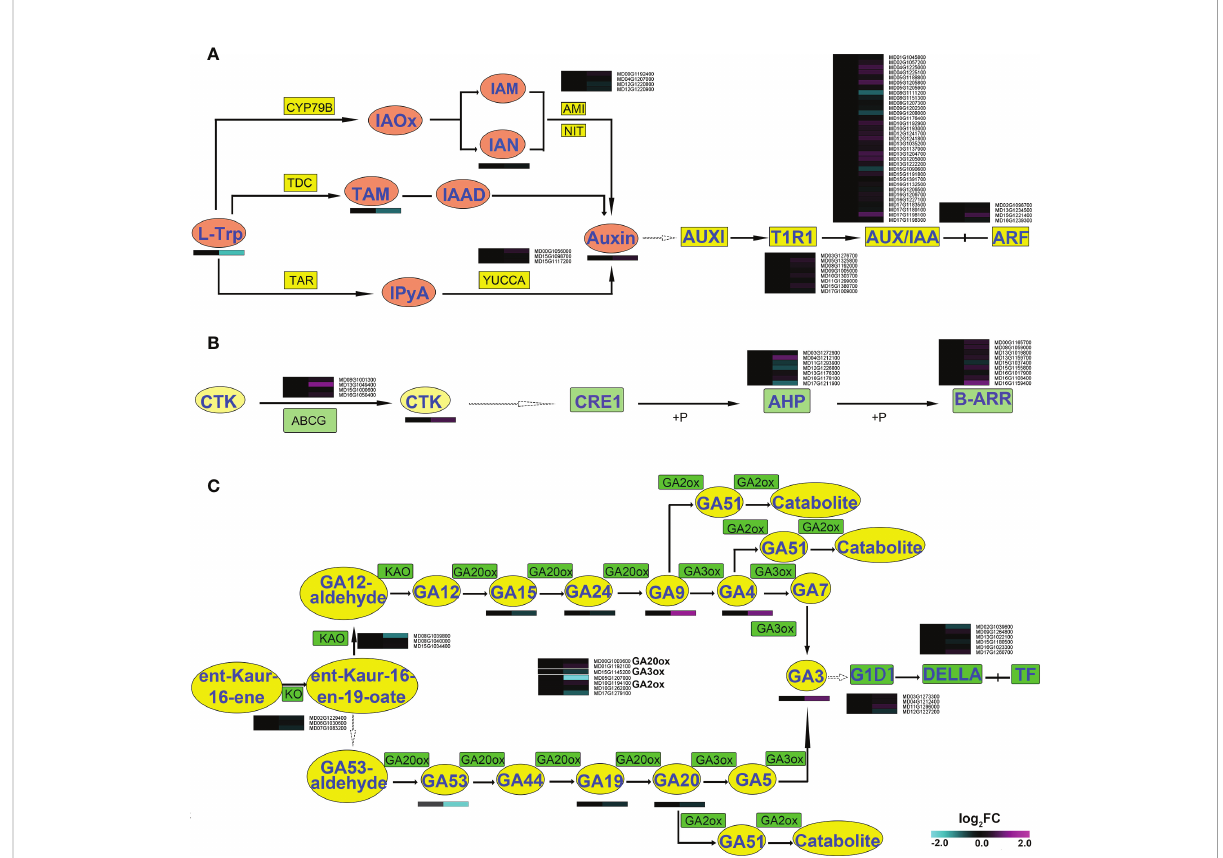
FIGURE 6 Synthesis, degradation, and transduction pathways of hormones in shoots of apple plants inoculated with R . irregularis for 60 days. (A) AMI1, amidase1; IAA, indole-3-acetic acid; IAAld, indole-3-acetaldehyde; IAM, indole-3-acetamide; IAN, indole-3-acetonitrile; IAOx, indole-3- acetaldoxime; IPyA, indole-3-pyruvic acid; L-Trp, L-tryptophan; NIT, nitrilase; TAR, tryptophan aminotransferase-related; TDC, tryptophan decarboxylase; TIR1, transport inhibitor response1; AUX/IAA, transcriptional regulator family protein; ARF, auxin response factors; (B) CTK, Cytokinin; ABCG, ABC transporter G family member; type-B ARRs, Arabidopsis response regulators; AHPs, Arabidopsis histidine phosphotransferase proteins; (C) GA, gibberellin; KAO, ent-kaurenoic acid oxidase; KO, ent-kaurene oxidase; GA20ox, GA 20-oxidase; GA3ox, GA 3-oxidase; GA2ox, GA 2-oxidase; gibberellin insensitive dwarf1, GID1; Gibberellic acid insensitive,